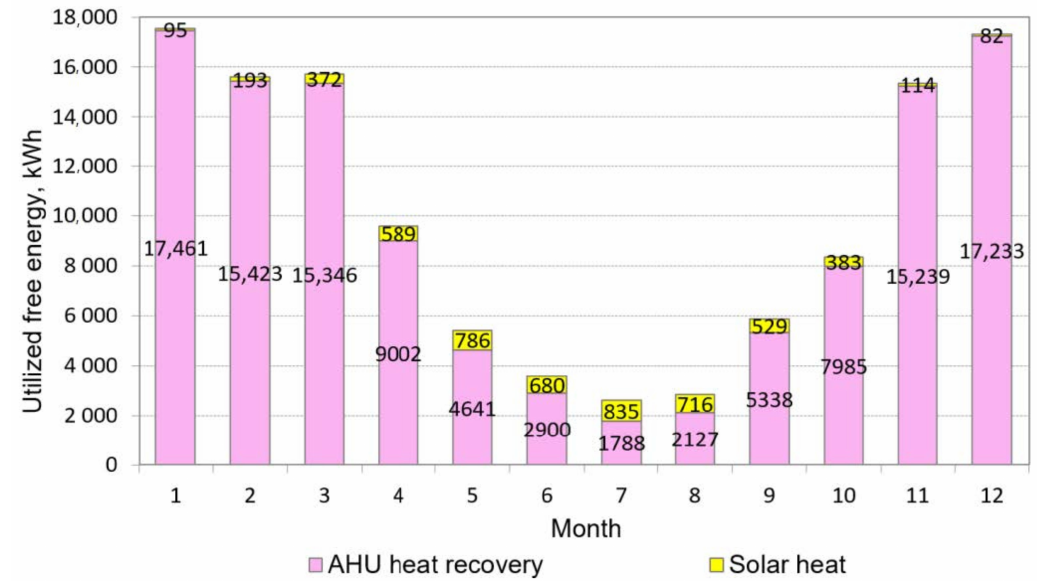
Figure 9. Monthly utilized free energy in the CEEE’s building.